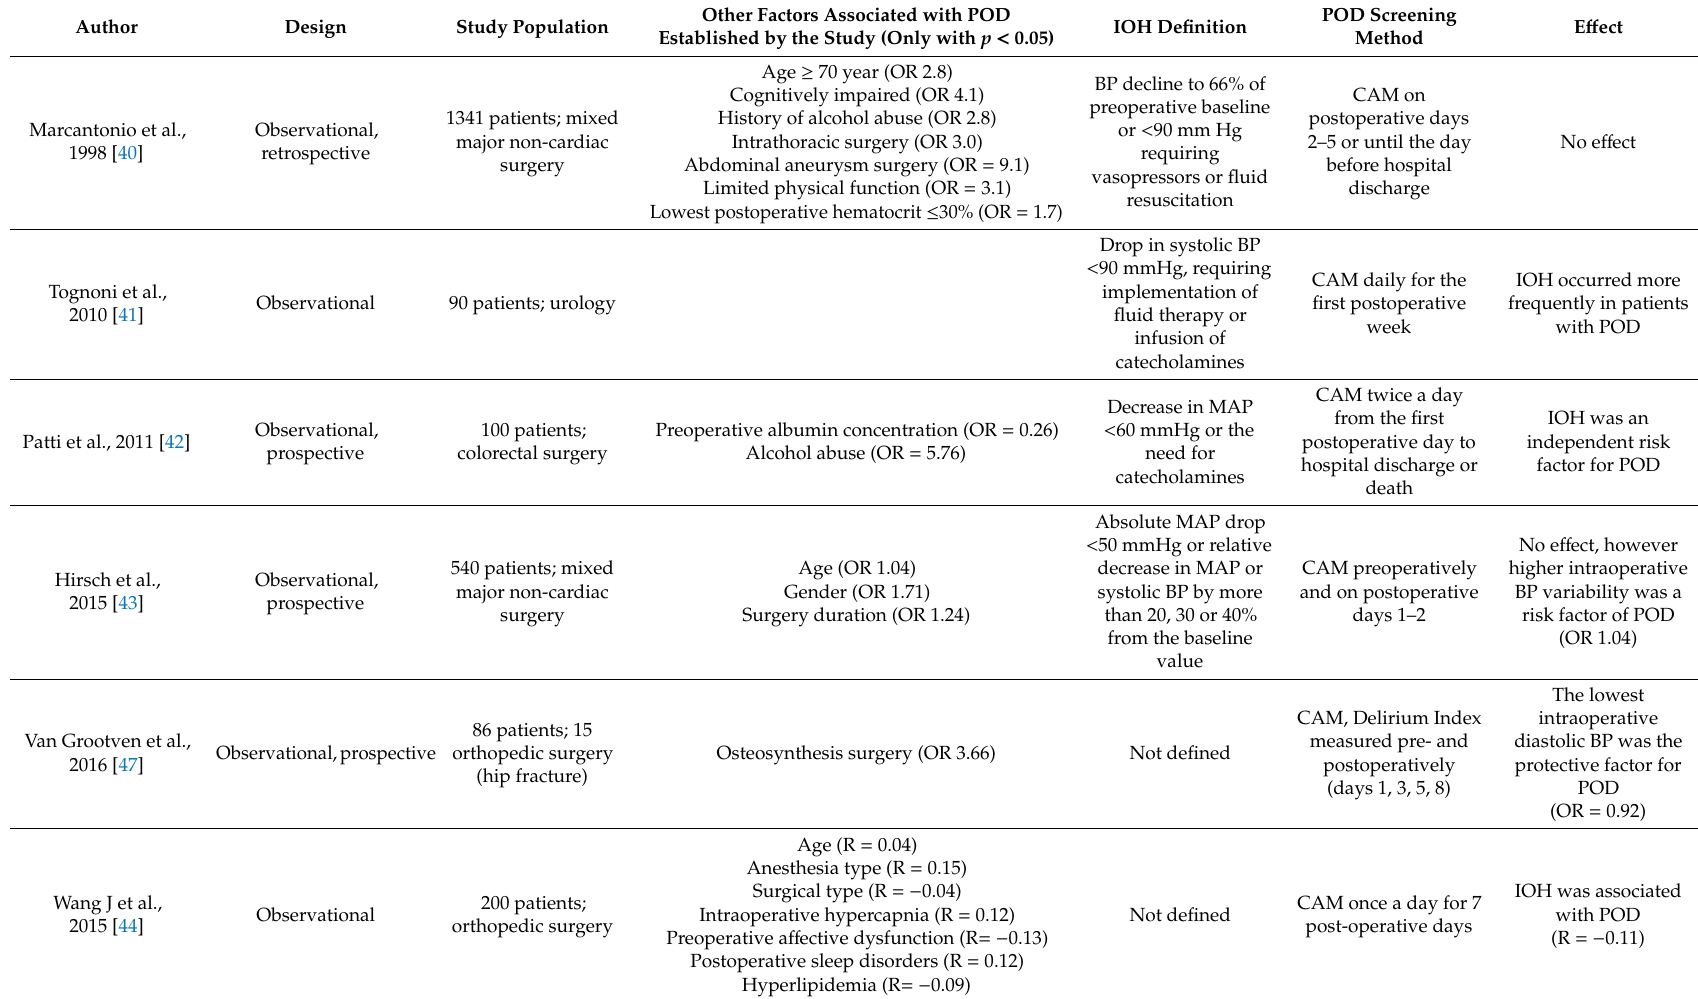
Table 6. Summary of studies on the association between intraoperative hypotension (IOH) or intraoperative blood pressure drop and postoperative delirium